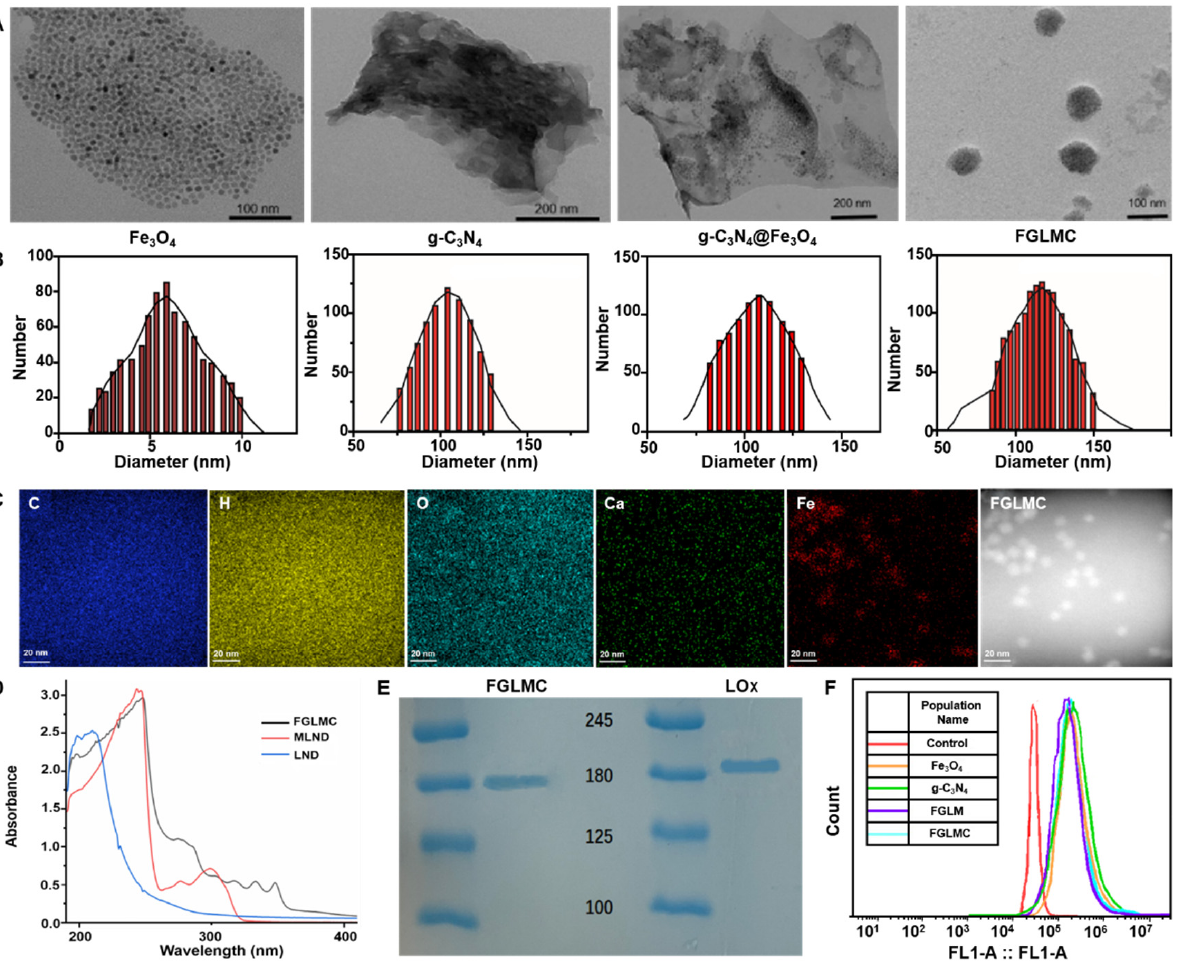
Figure 1. Material characterization. ( A ) TEM images and ( B ) Hydrodynamic diameters of Fe 3 O 4 , g-C 3 N 4 , Fe 3 O 4 @g-C 3 N 4, and FGLMC . ( C ) TEM-Element mapping of FGLMC (scale bar: 20 nm). ( D ) UV-vis absorption spectra of LND, MLND and FGLMC . ( E ) SDS-PAGE protein analysis of LOx. ( F ) Mitochondrial membrane potential detection.